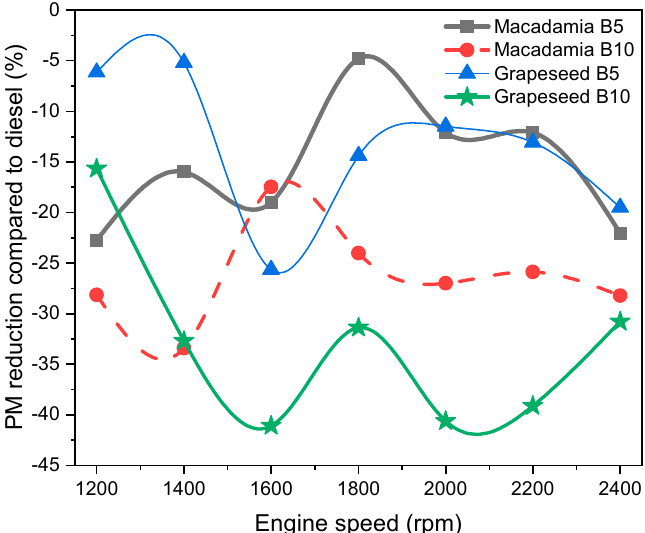
Figure 8. Particulate matters (PM) emission reduction compared to diesel using B5 and B10 biodiesel blends. Energies 2020 , 13 , 2748